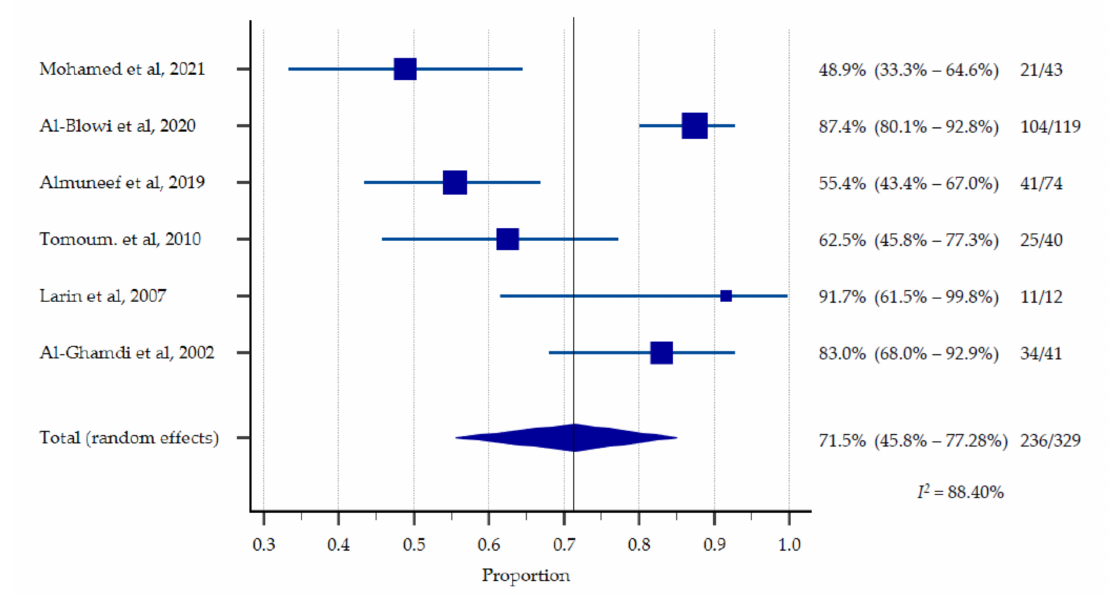
Figure 2. Presence of at least one form of malnutrition (%).